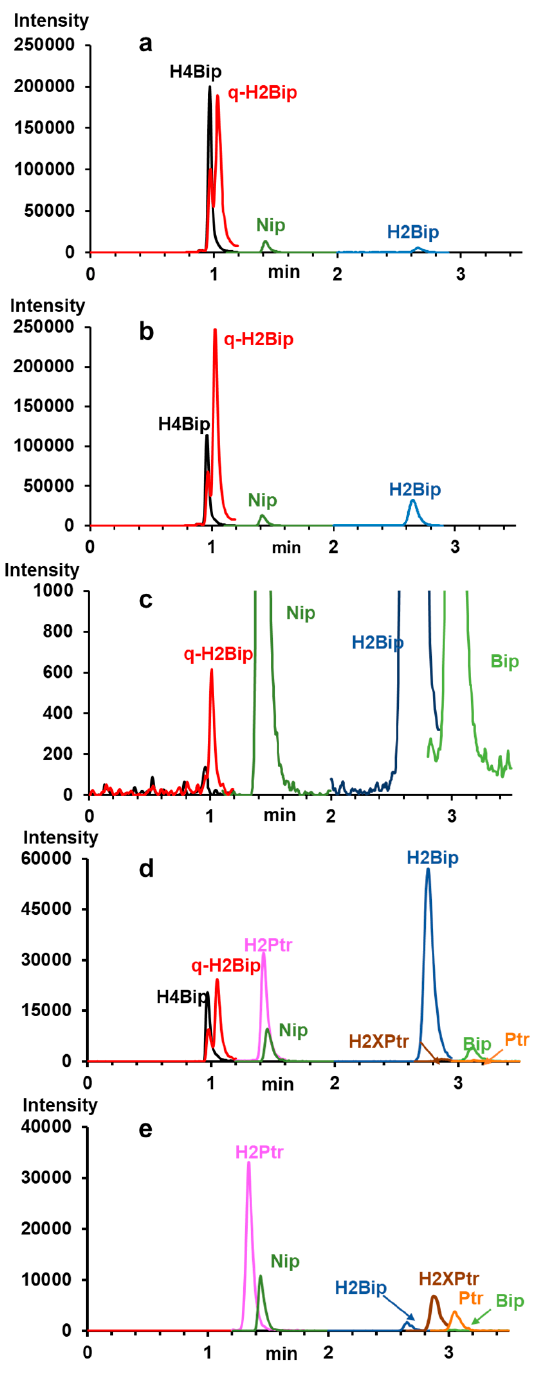
Figure 2. Chromatographic profiles of H4Bip working solutions prepared and incubated in 0.1 M ammonium formate buffer at ( a ) pH 2.8 at time 0; ( b ) pH 2.8, after 1 h of incubation; ( c ) pH 2.8, after 10 h of incubation (zoom-in on the peak of residual qH2Bip); ( d ) pH 5.4 after 1.6 h of incubation; ( e ) pH 7.4 after 49.4 h of incubation. Chromatographic conditions are detailed in the experimental